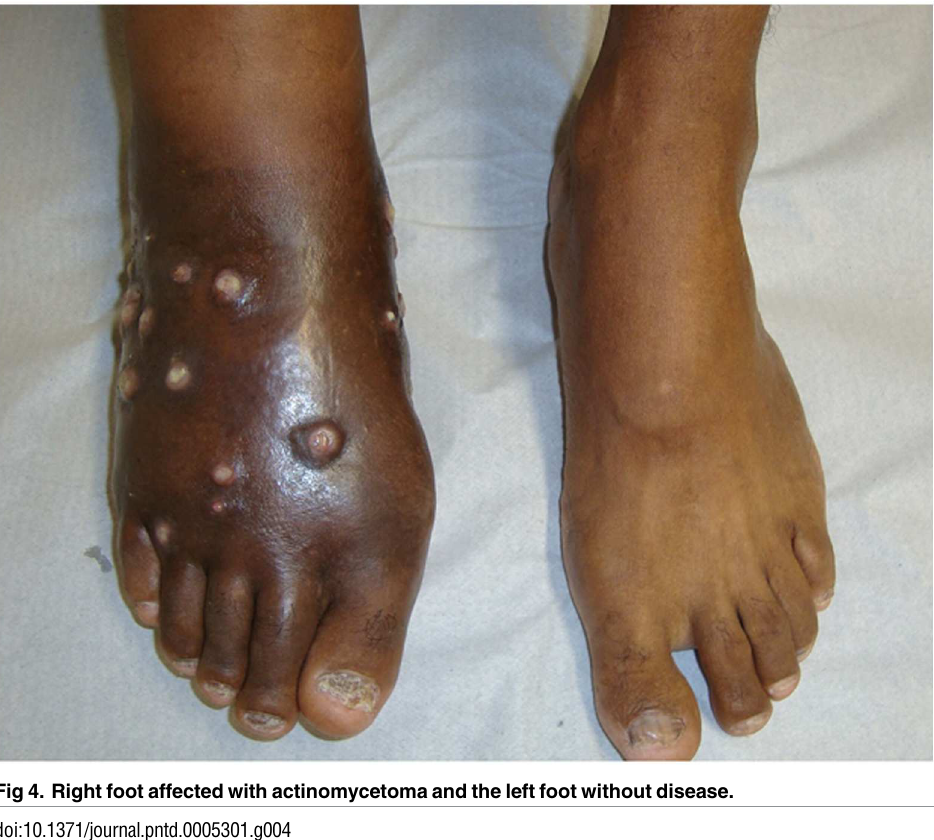
Fig 4. Right foot affected with actinomycetoma and the left foot without disease.